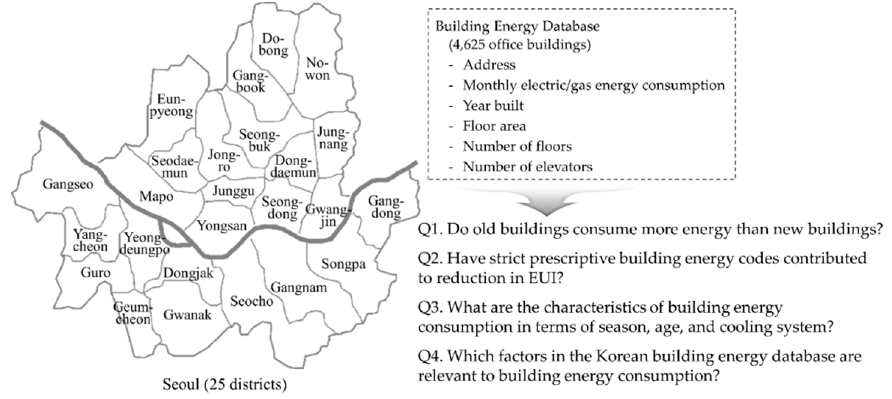
Figure 1. Questions addressed in this study based on 4625 office buildings located in 25 districts in Seoul, Korea.